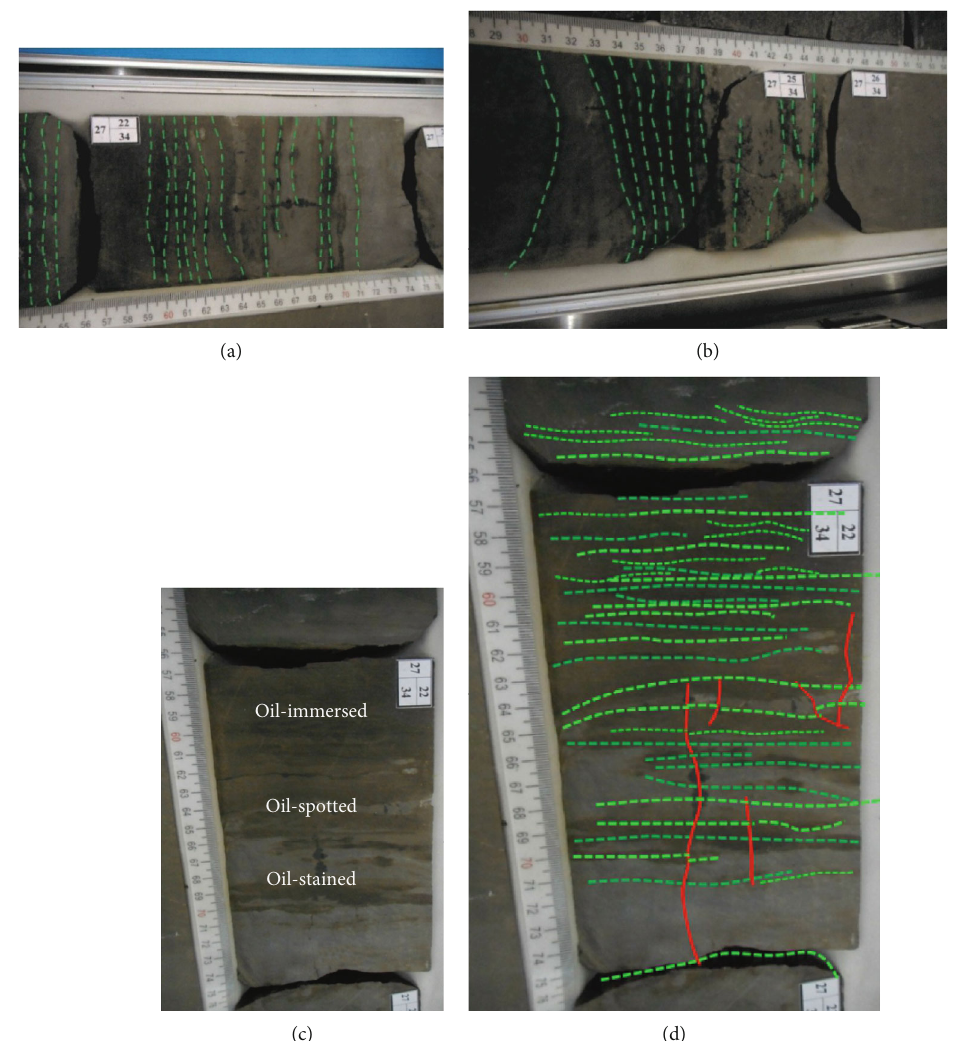
Figure 10: Core photographs of Lucaogou formation in Jimsar sag. (a) Ji174, 3305.8m; (b) Ji174, 3307.2m; (c) core photograph of Ji174, 3305.1m; (d) interpreted core photograph of Ji174, 3305.1m.